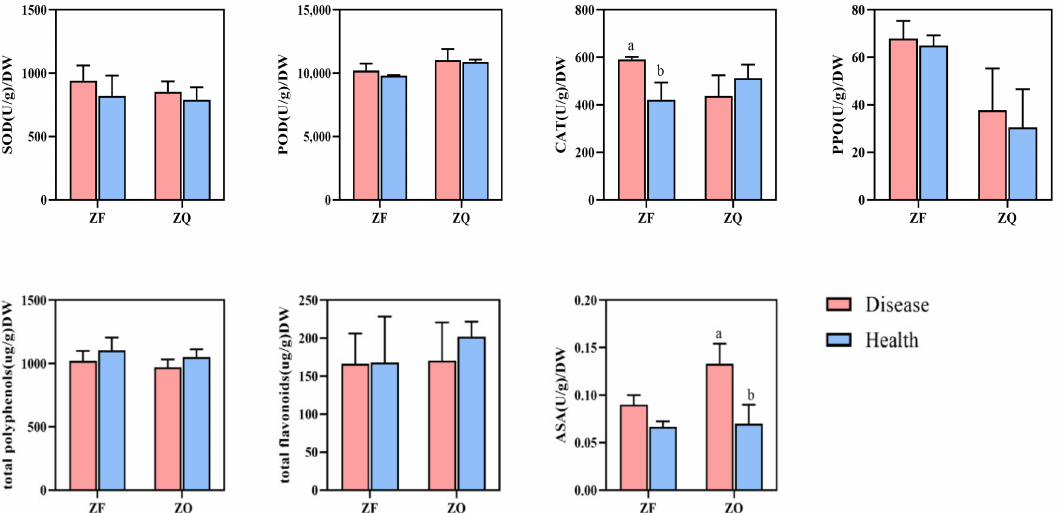
Figure 4. Changes in nut nutrients and antioxidants in healthy and diseased chestnut trees. The significance of difference was labeled as ‘a’ and ‘b’ between healthy and diseased trees.